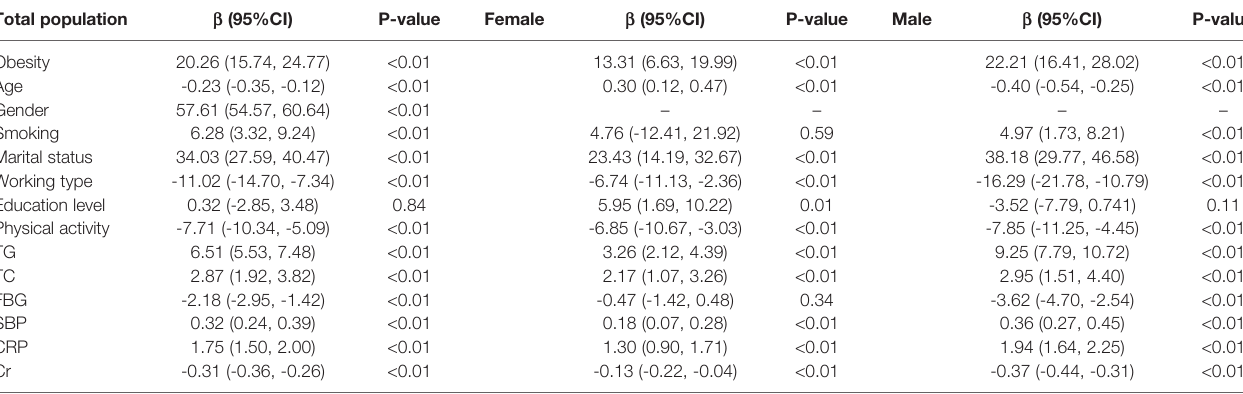
CI, Con fi dence Interval; Cr, Creatinine; CRP, C-reactive Protein; FBG, Fasting Blood Glucose; Obesity: body mass index ≥ 28kg/m 2 ; SBP, Systolic Blood Pressure; SUA, Serum Uric Acid; TC, Total Cholesterol; TG, Triglyceride.